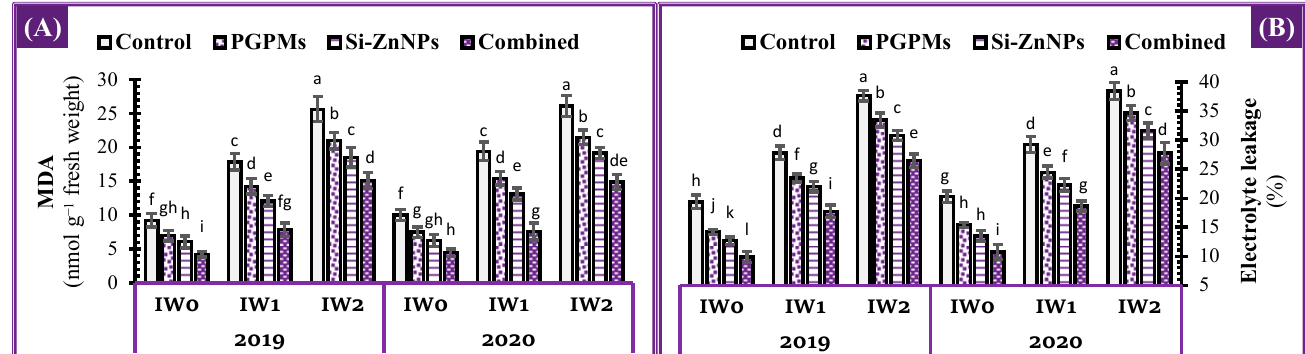
Figure 6. Influence of application of PGPMs, Si-ZnNPs and their combination on oxidative damage indicators, i.e., ( A ) malondialdehyde (MDA), and ( B ) electrolyte leakage (EL%) in the leaves of soybean plant grown in salt-affected soil with different levels of watering intervals ( IW 0 ; 11 days, IW 1 ; 15 days, and IW 2 ; 19 days) during the successive 2019 and 2020 growing seasons. The data presented as means ± SD. Means labeled with the same lower-case letter are not significantly different according to Duncan’s Multiple Range Test.